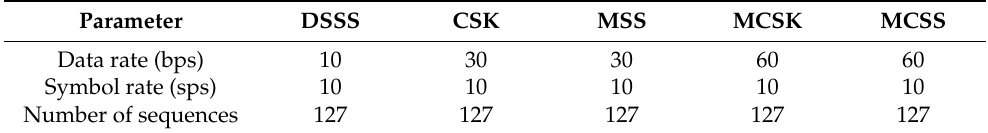
Table 4. Transmission signal parameters.